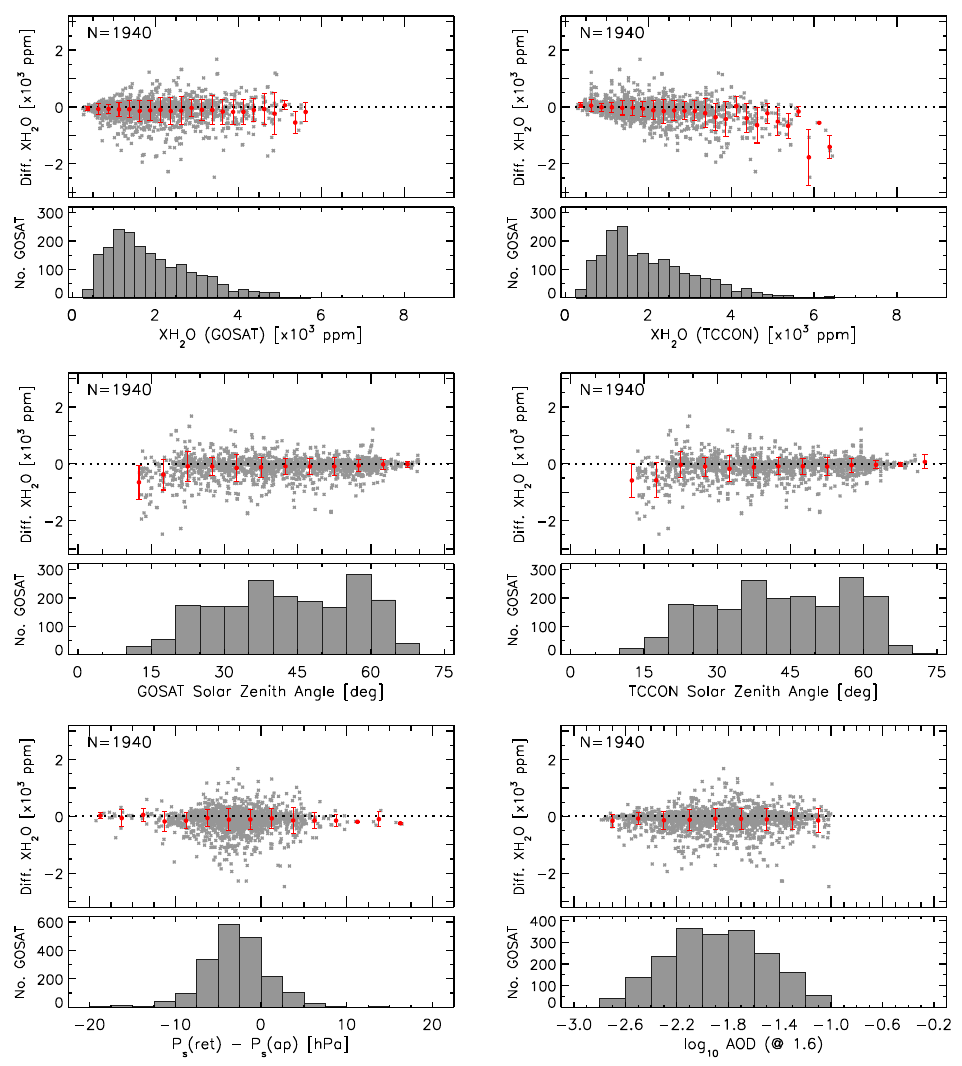
Figure 10. Evolution of the XH 2 O absolute differences (GOSAT − TCCON) for the nominal coincidence criteria ( ± 1 ◦ latitude/longitude and ± 30min), as a function of geophysical and retrieval parameters: the TANSO-FTS and TCCON XH 2 O (top row), the solar zenith angle values for GOSAT and TCCON (middle row), the difference between the retrieved and the a priori values for the surface pressure (bottom left) and the aerosol optical depth at 1.6 µ m retrieved from the TANSO-FTS spectra (bottom right). The corresponding histograms of the number of TANSO-FTS scans are plotted below each panel. The grey dots represent the single-scan differences; the red symbols with “error bars” show the average value and associated standard deviation within each histogram